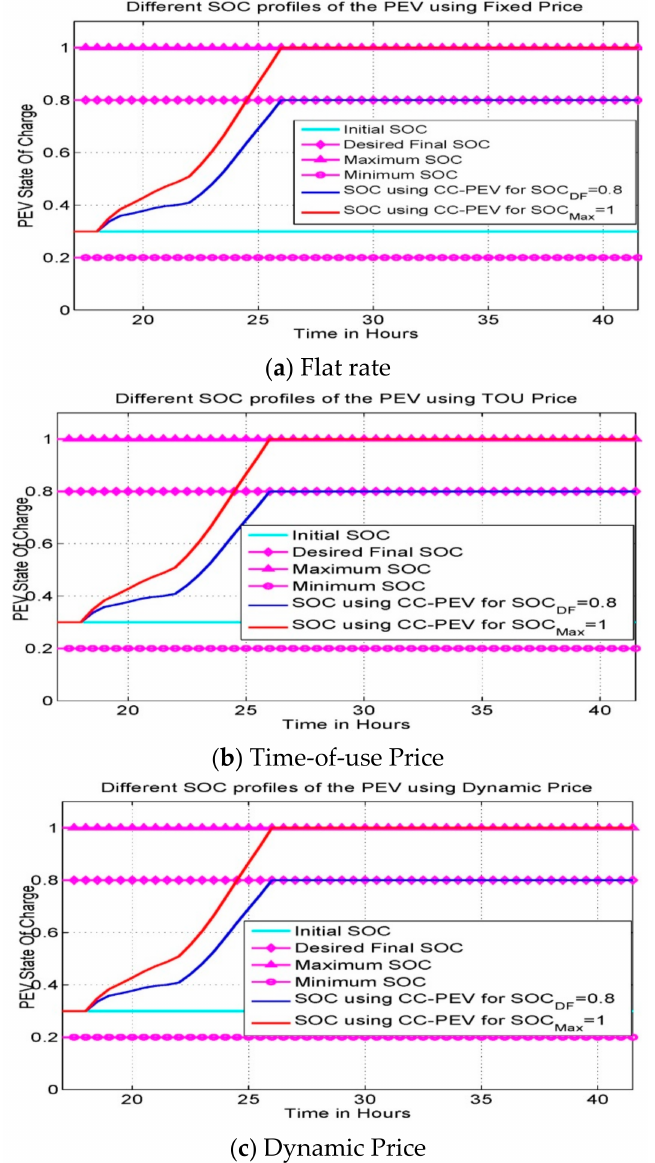
Figure 6. SOC of the Battery for SOC Max = 1 and SOC D = 0.8, for ( a ) Flate rate, ( b ) TOU, ( c ) Dy- namic